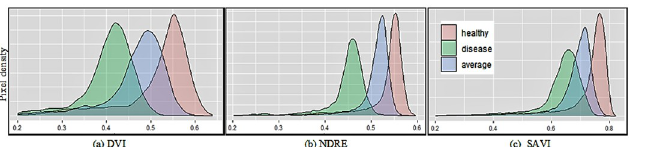
Fig 6. The sample plot distribution of three kinds of plots: Healthy, average, and highly diseased plots. Note that the density plots are drawn by taking an average of five randomly chosen plots for each category of plots from the image taken at DAP-96. Note that the plots with disease scores (1-2), (3-5) and (6-9) are considered healthy, moderately diseased and severely diseased plots respectively for this illustration.